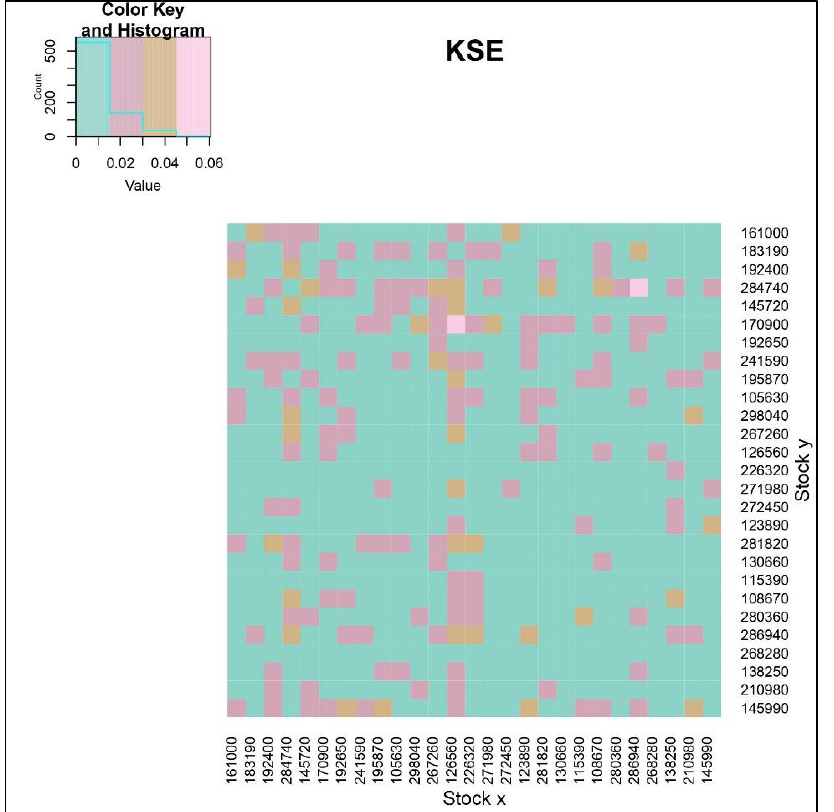
Figure 12. The information flow (effective transfer entropy) from stock y to stock x, for the top companies (by market capitalization) in the KSE market, after the COVID-19